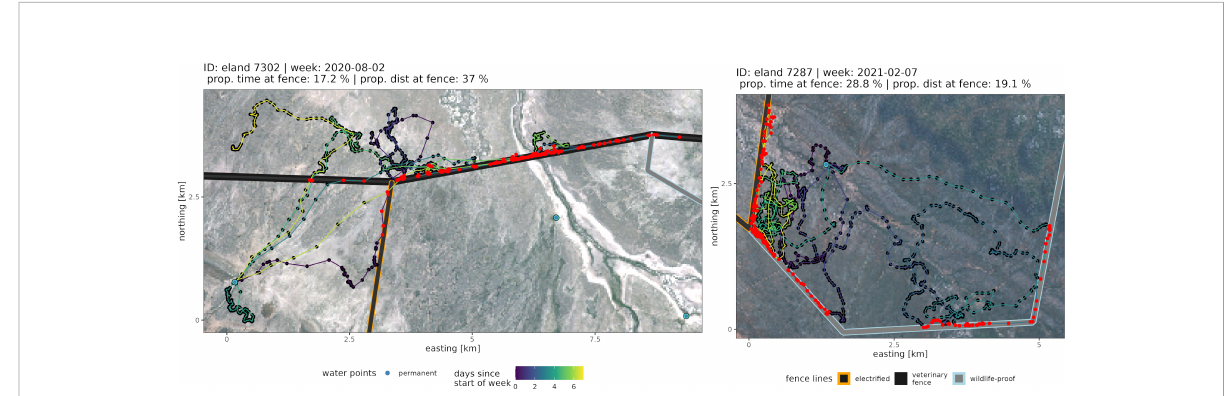
FIGURE 7 Example weekly movement paths of weeks with either very long distances moved along fence lines (left) or times spent at fence lines (right). Red points depict localizations related to a fence interaction event. Further details are shown in panel titles or within the legends. Background Sentinel 2 (Bands 3,4,5) image, March 2020 (contains modi fi ed Copernicus Sentinel data [2020]).